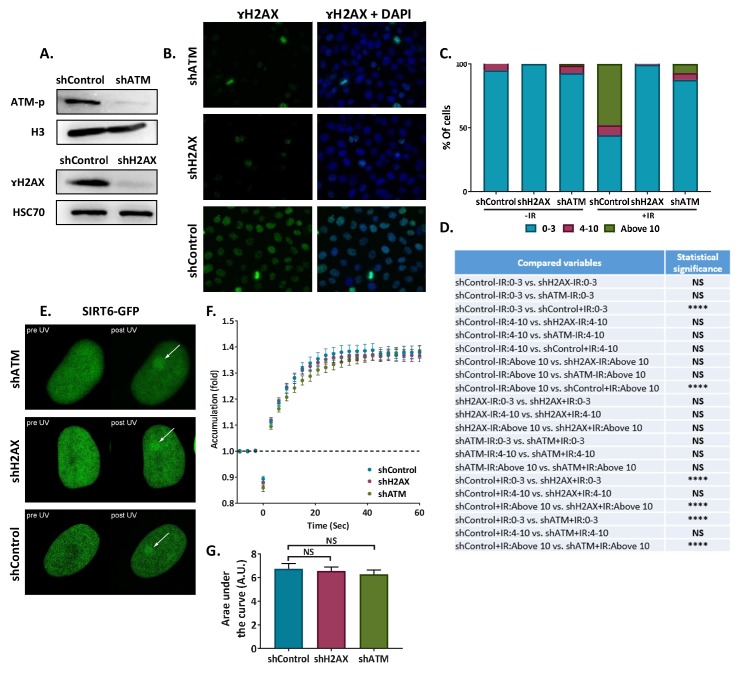
SIRT6 arrivesatsites of damage independently of other repair factors.(A) Blot of shATM, shH2AX and shcControl Hela cells. (B) Immunofluorescence of γH2AX in sh-Hela cells upon irradiation (IR). (C) Quantification of γH2AX foci in Control (n[–IR]=283, n[+IR]=301), shH2AX (n[–IR]=284, n[+IR]=322) and shATM (n[–IR]=299, n[+IR]=385) Hela cells. The bar chart shows the percentages of cells with 0–3, 4–10 or more than 10 foci per nucleus (+/- IR, average of six experiments). (D) Statistical analysis of the γH2AX foci quantification experiment depicted in panel (C) (*, p < 0.05; **, p <0.005, ***, p < 0.0005). (E,F) Representative experiment showing SIRT6-GFP accumulation in response to LID in shH2AX (n = 10), shATM (n = 10) or shControl (n = 10) cells. (G) Average AUC for three replicate experiments. Error bars are SEM (shControl: n = 30; shH2AX: n = 30, p>0.05; shATM: n = 30, p>0.05).